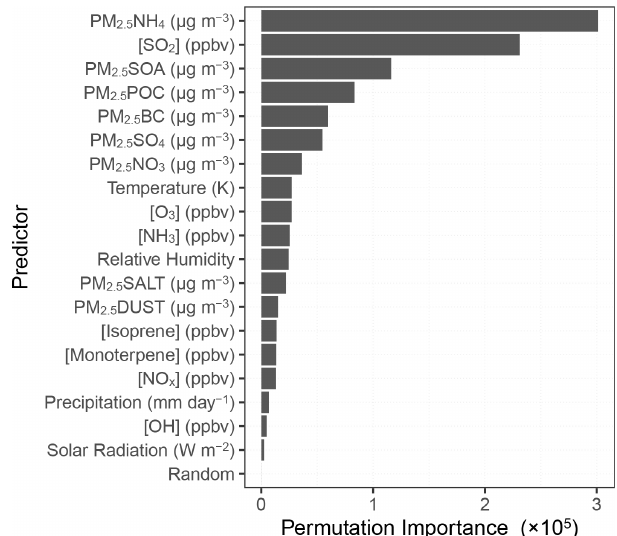
Figure 6. Importance (in decreasing order) of each predictor in the RFRM derivation of [CCN0.4].